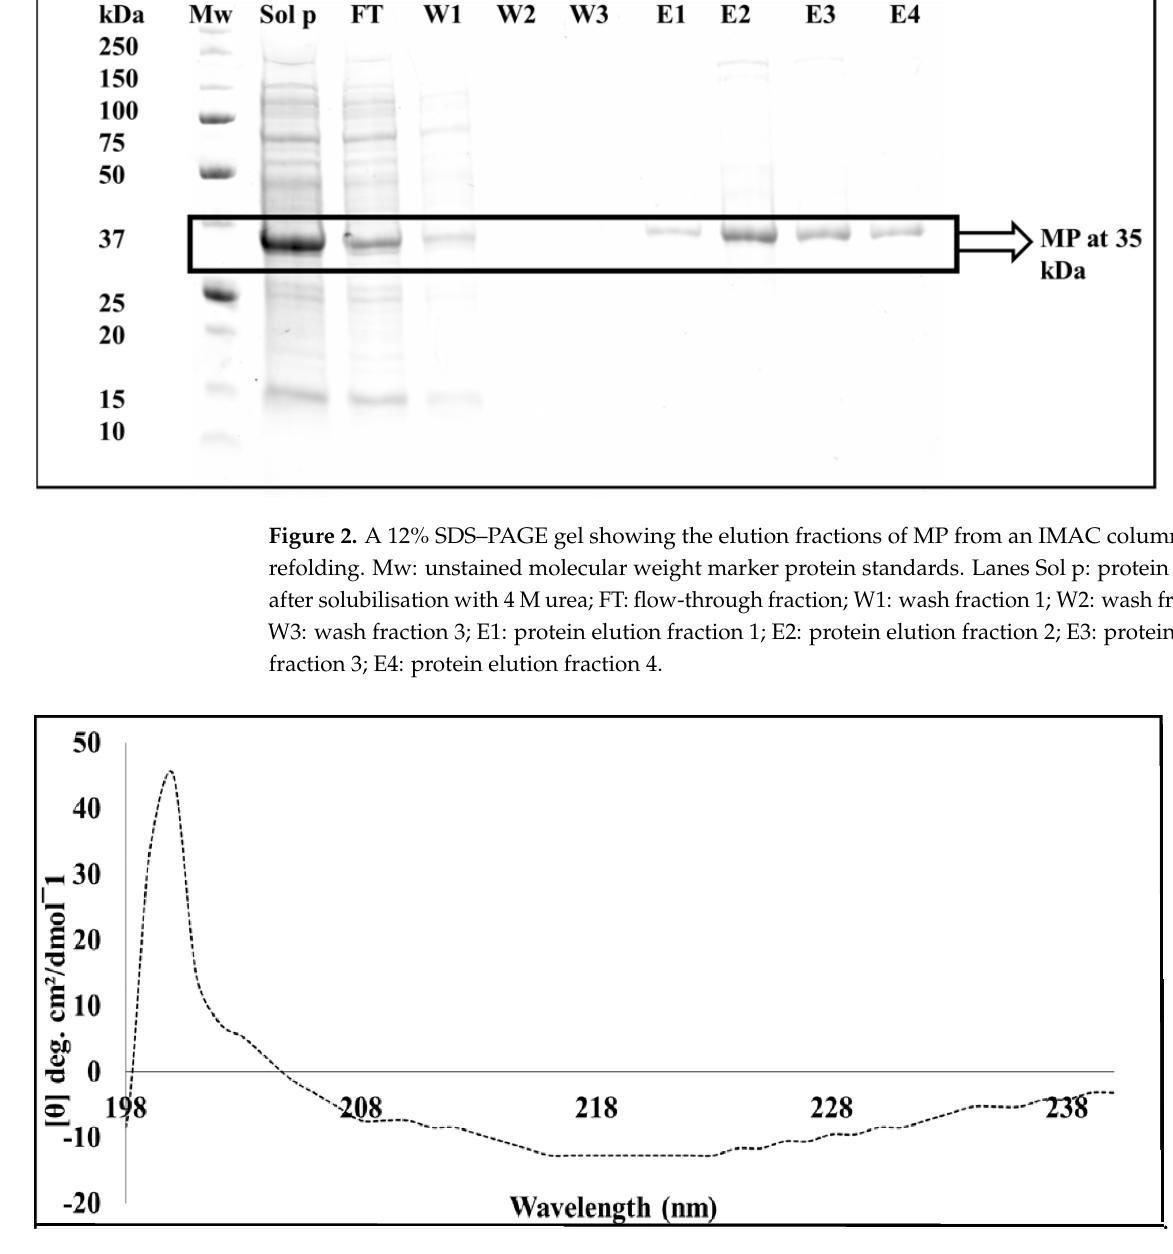
Figure 3. Far-UV CD spectrum of SACMV BC1. Signals were collected using 5 μM of protein in 0.5 mM Tris-HCl buffer, pH 7.5. The spectrum indicates that the protein displays a secondary structure which is predominantly β -strand.